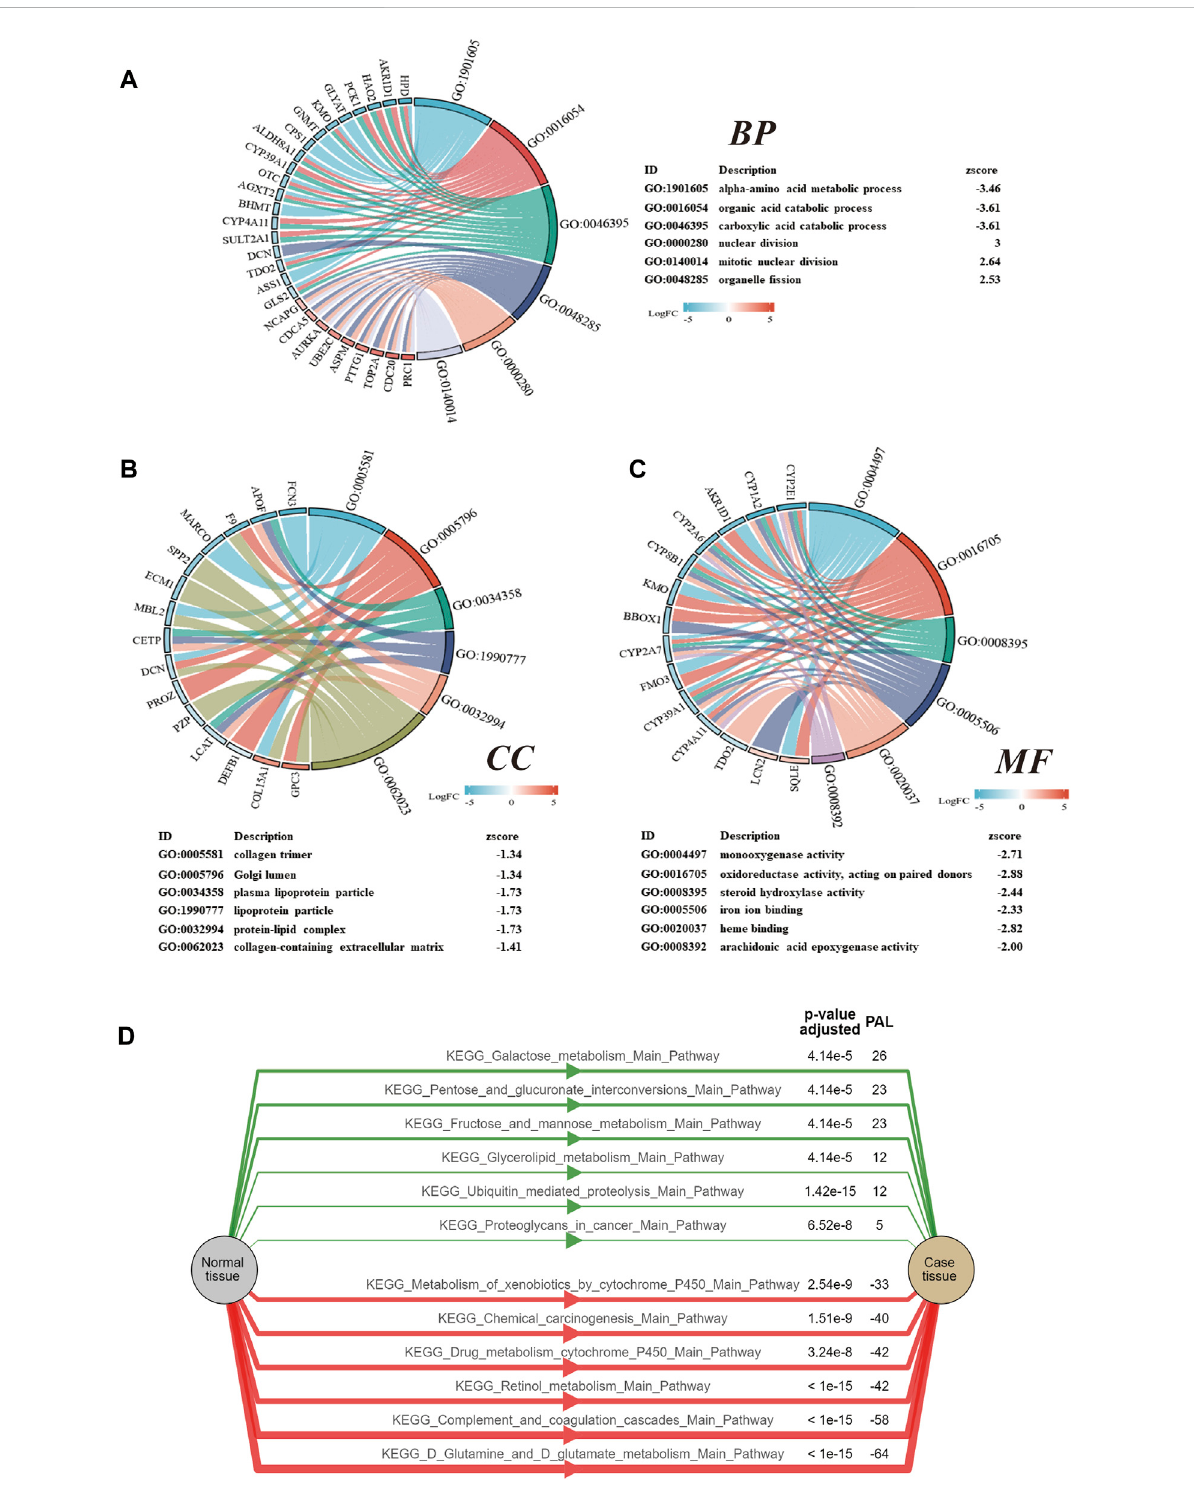
FIGURE 2 GO and KEGG analyses of the DEGs. (A) Chord diagrams of the biological process. (B) Chord diagrams of the cellular components. (C) Chord diagrams of the molecular function. (D) KEGG pathway analysis of the DEGs. A positive value for PAL indicates activation of the pathway, while a negative value indicates inhibition of the